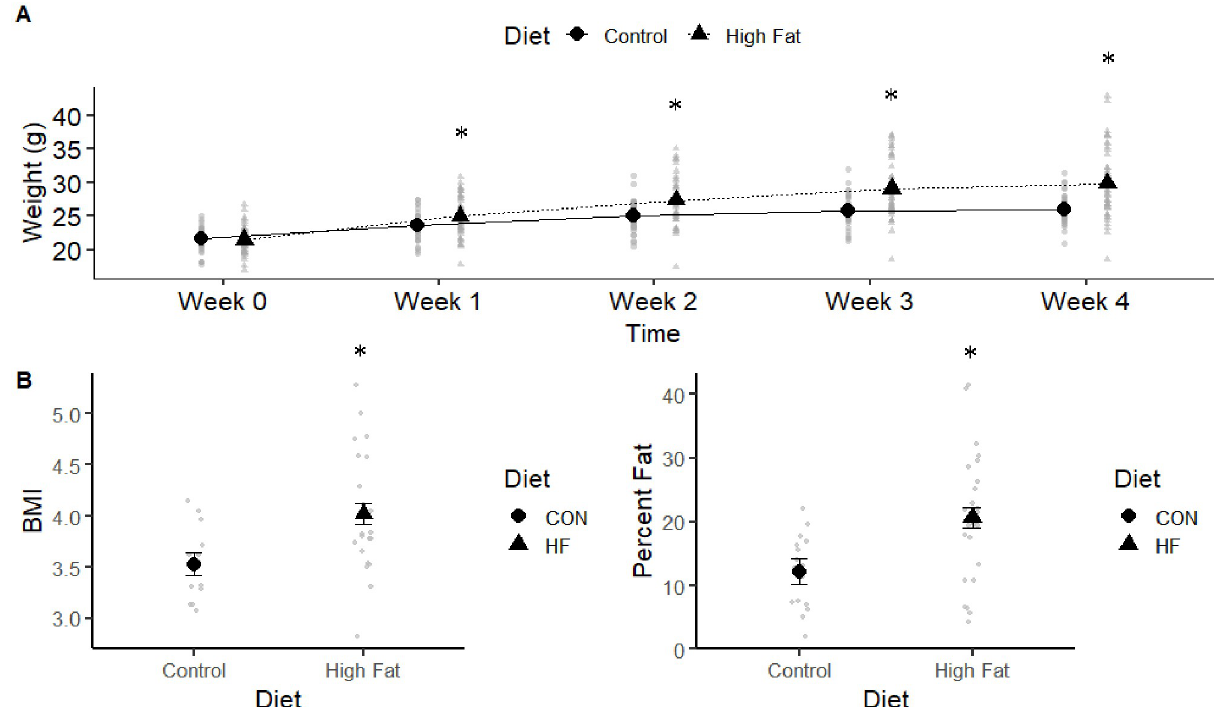
Fig 1. Effect of diet on body weight and composition over four weeks. A) Average weight by week, from the onset of experimental diets until 4 weeks across both cohort 1 and 2, CON (n = 36) and HF (n = 49). On week one and after, CON and HF weights are different (P < 0.05), as determined by mixed model and post-hoc analysis. B) BMI measurements (ratio of weight to length) at the end of the four-week period, cohort 1 mice, CON (n = 18) and HF (n = 24). C) Percent fat, as measured by EchoMRI in cohort 2, CON (n = 18) and HF (n = 25). � indicates significant results (P < 0.05).